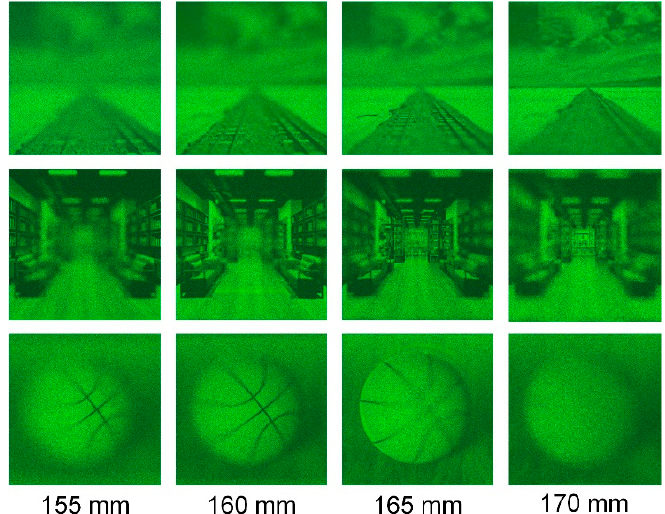
Figure 4. Reconstructions of 3D scenes by 2D-to-3D rendering method at depths of 155 mm, 160 mm, 165 mm and 170 mm, respectively.